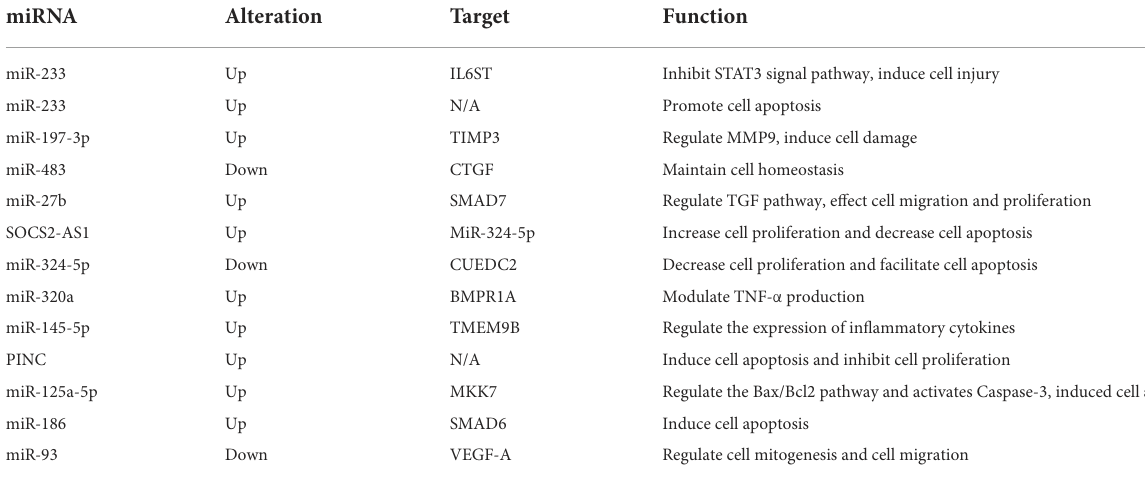
TABLE 1 Non-coding RNAs regulates vascular endothelial cell injury and maintain in KD.